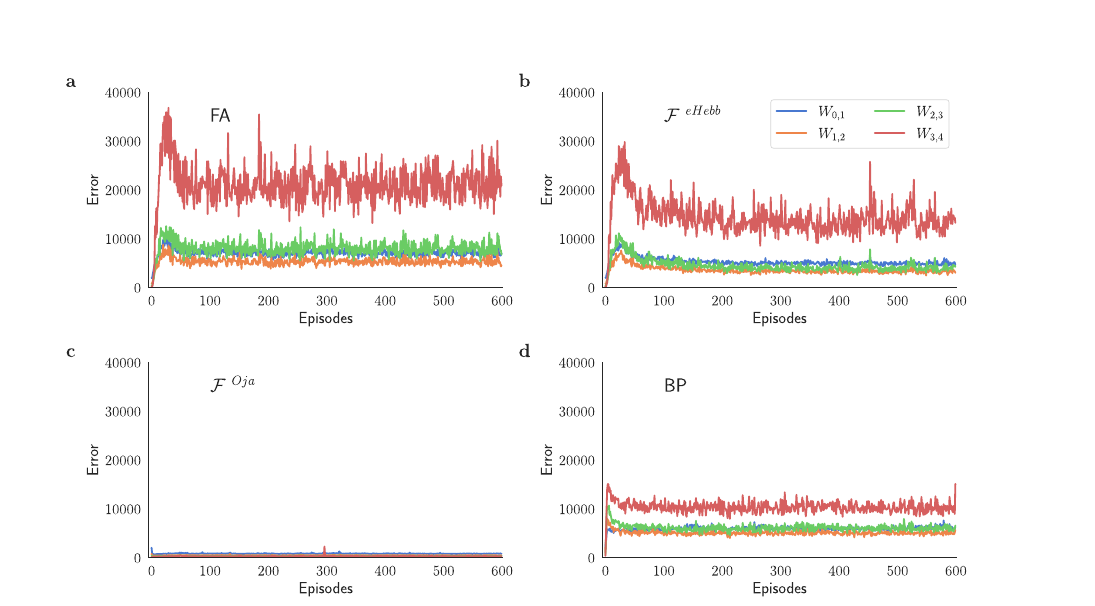
c , along with Fig. 7c, demonstrate the role of Oja ’ s rule in improving the model ’ s performance through improved feature extraction. All panels present the mean errorovermultiple trials(seeMethods).In this comparison,the last layer has been